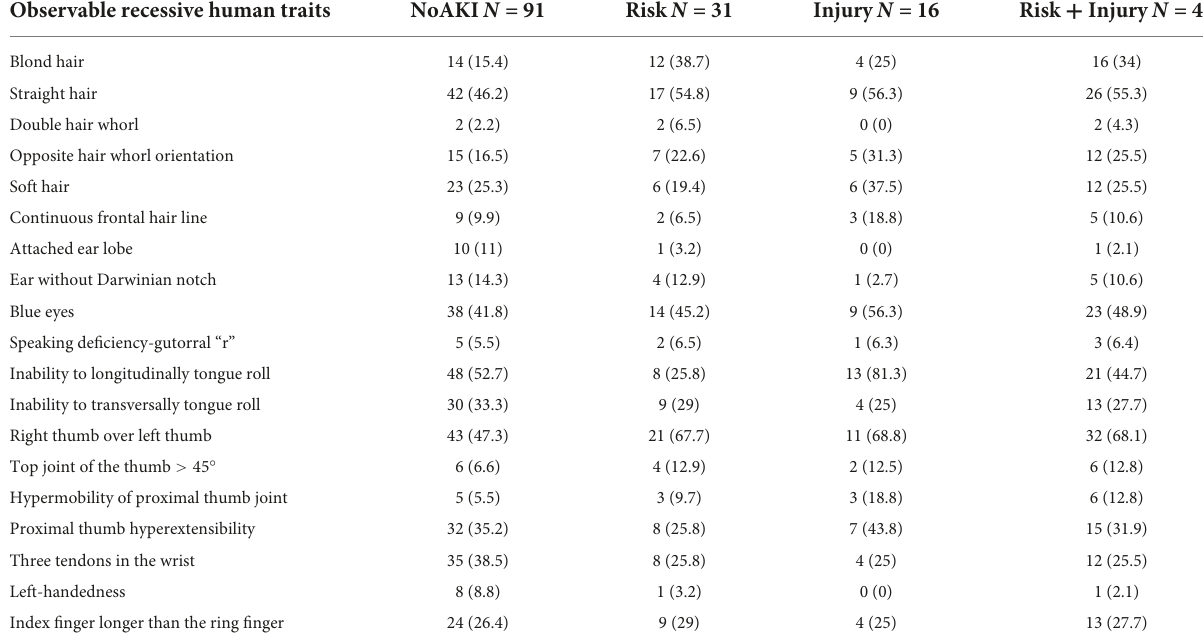
TABLE 2 Frequencies of observable recessive human traits among patients with presence and severity degree of acute kidney injury. Observable recessive human